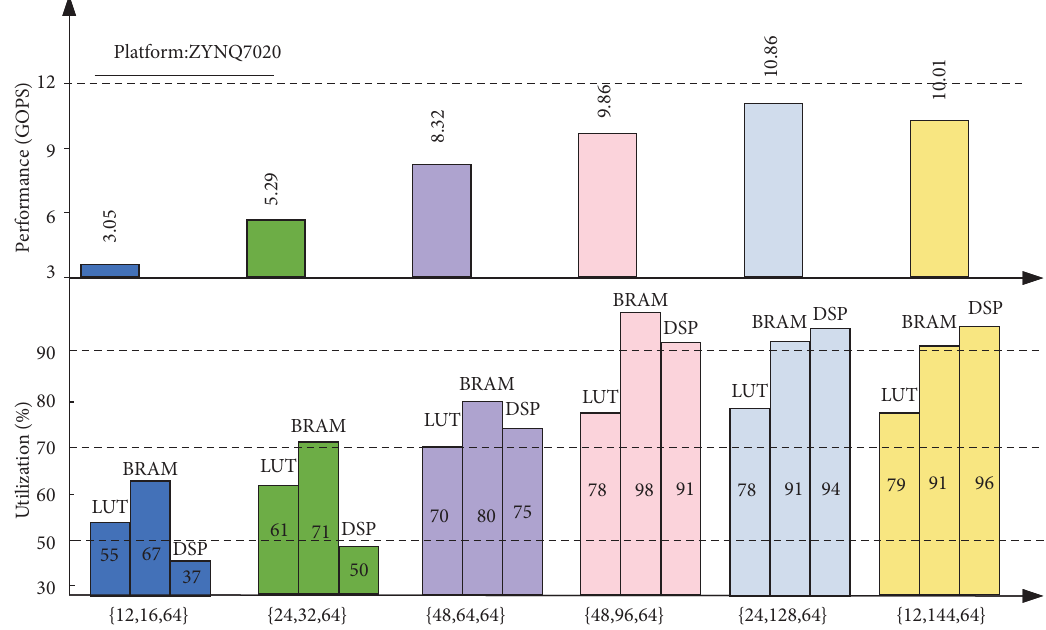
,N , N 􏼈 􏼉 , 1 2 3 is the com- 3